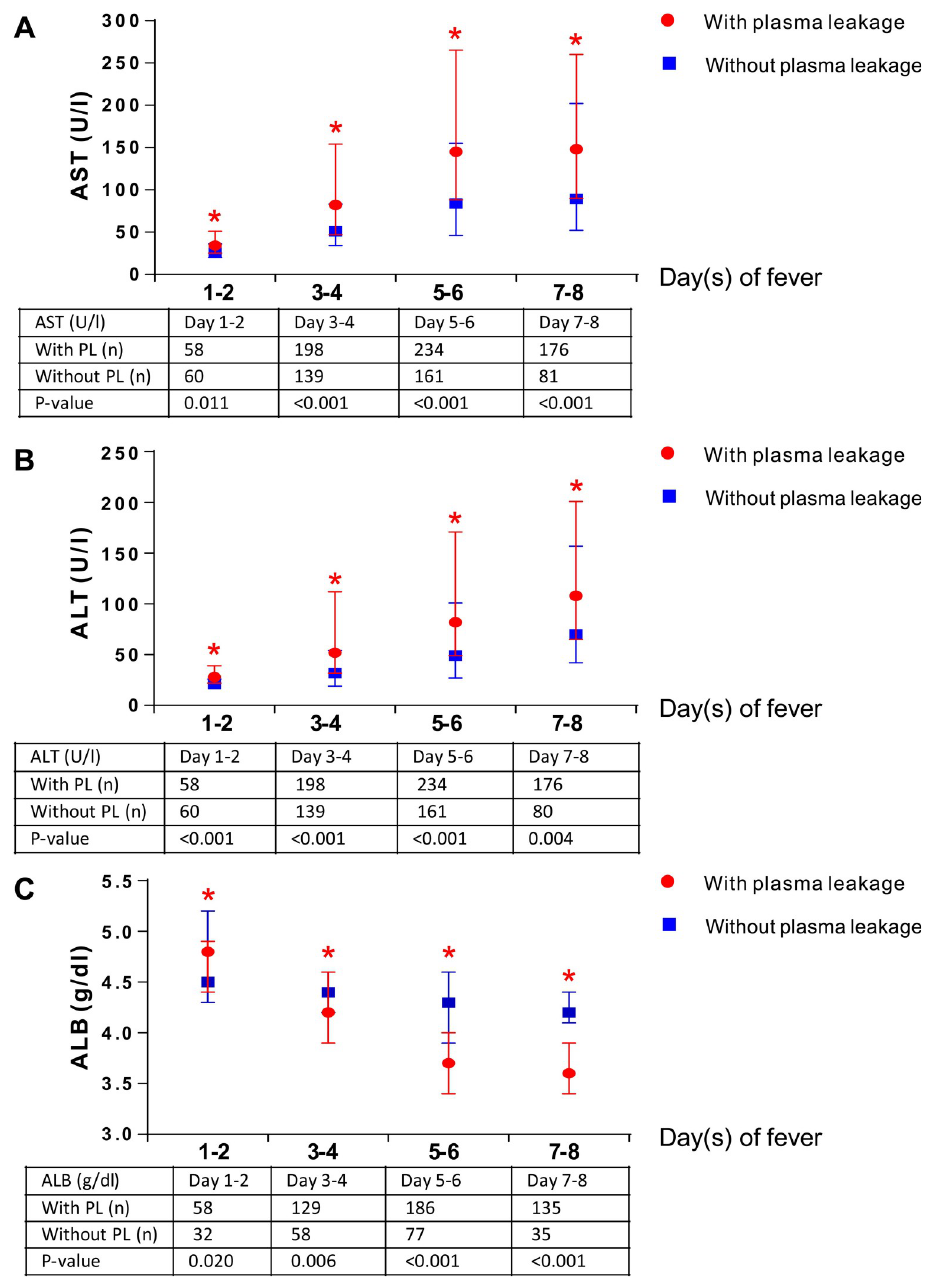
Fig 3. Changes in aspartate aminotransferase, alanine aminotransferase, and serum albumin levels among confirmed dengue patients by combined day of fever onset. (a) The highest level of AST (U/l) by combined day of fever onset among patients with and without plasma leakage. (b) The highest level of ALT (U/l) by combined day of fever onset among patients with and without plasma leakage. (c) The lowest level of serum ALB (g/dl) by combined day of fever onset among patients with and without plasma leakage. ALB, albumin; ALT, alanine aminotransferase; AST, aspartate aminotransferase; PL, plasma leakage.